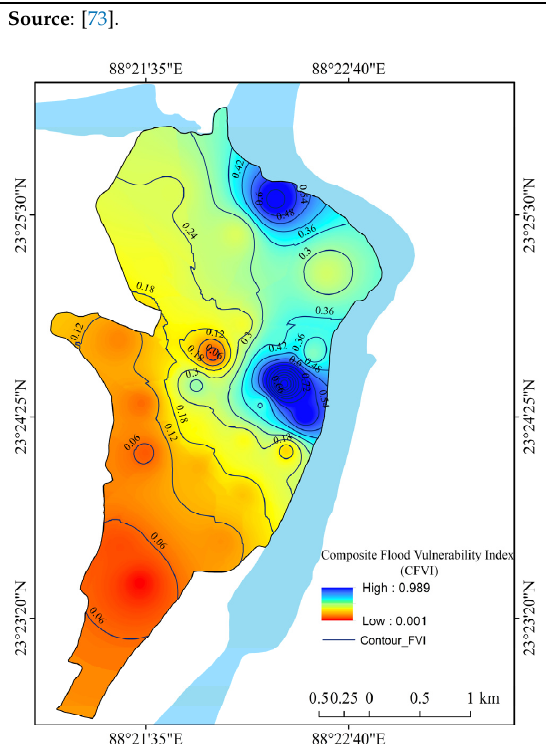
Figure 47. Isoline of CFVI (2015).